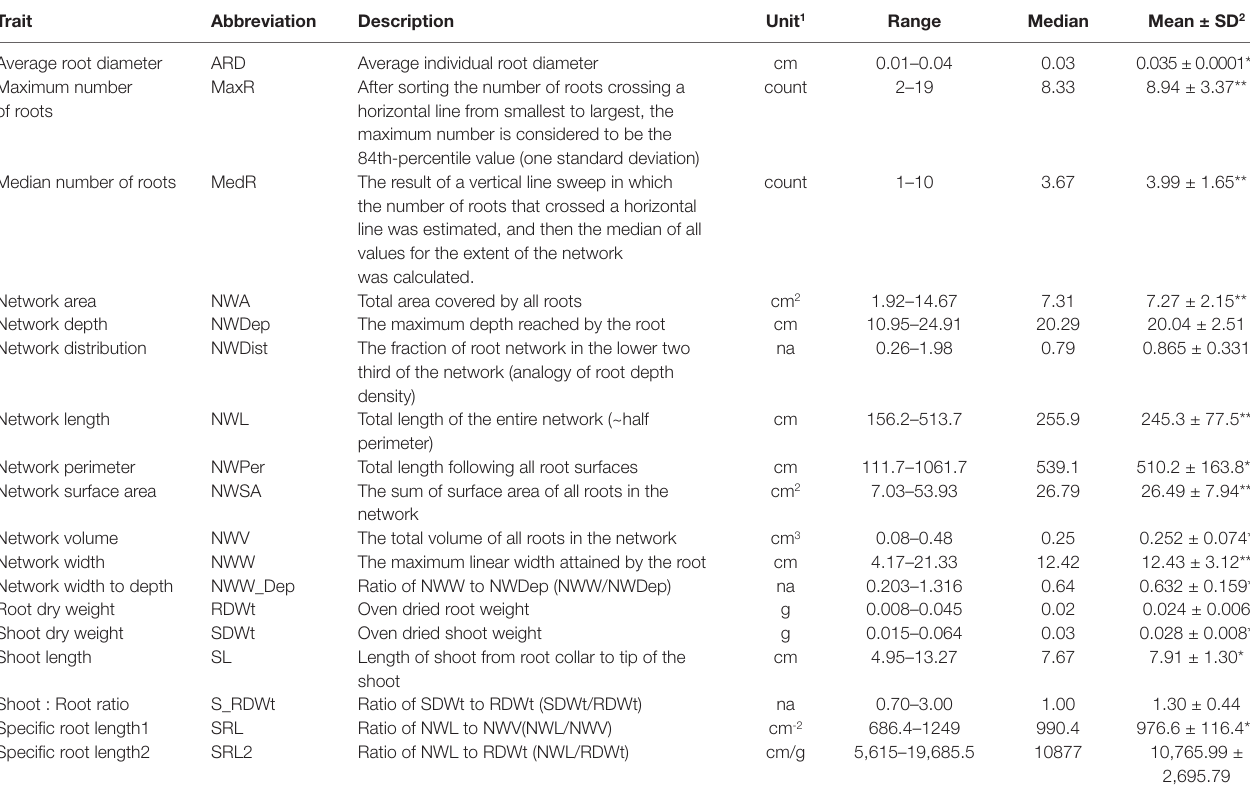
TABlE 1 | Phenotypic traits and their basic statistics of three replicates of the 111 accessions of the flax mini-core collection.